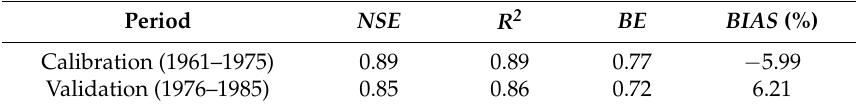
Figure 6. Scatter diagrams between observed and simulated monthly runoffs in the calibration ( a ) and validation periods ( b ) for the URRB. Table 3. Performance of the hydrological model for the daily runoff simulation in the URRB.